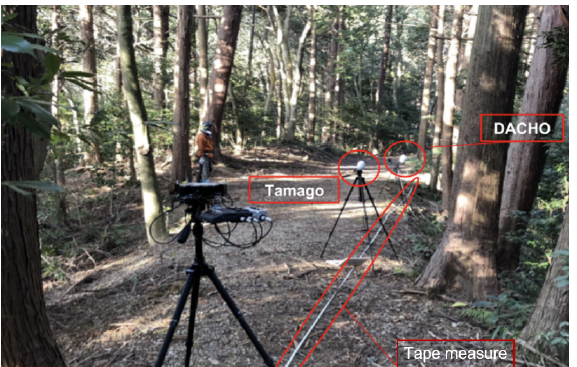
Figure 1. A snapshot of the experiment. We used DACHO, a 16-ch microphone array, for recording replayed songs from a loudspeaker.